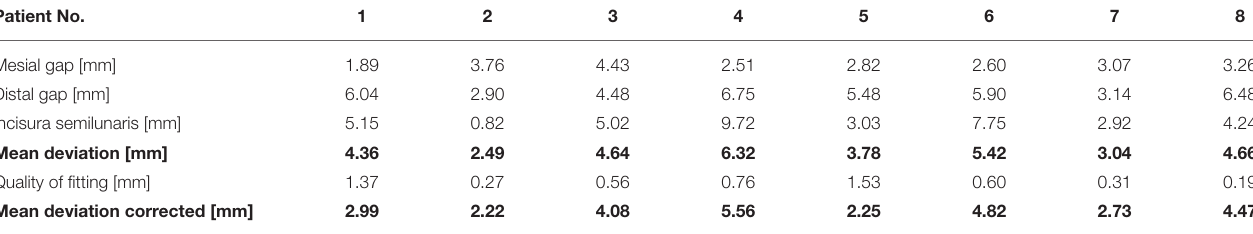
TABLE 2 | Precision Analysis. Patient No.